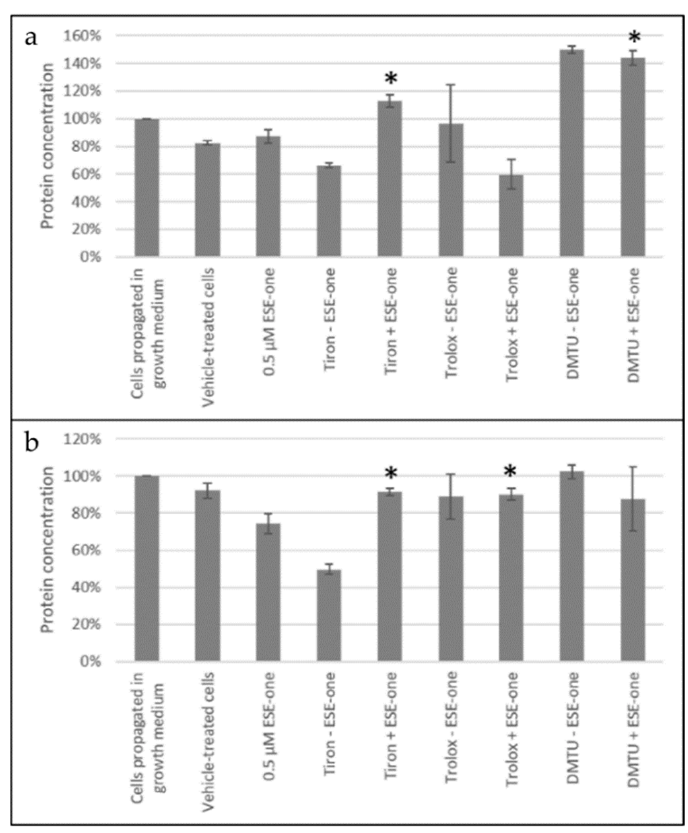
Figure 7. Catalase activity graphs of MCF-7 and MDA-MB-231 cells exposed to ESE-one in the presence or absence of scavengers of reactive oxygen species (tiron, trolox and DMTU). Tiron and DMTU coexposure with ESE-one increased the catalase protein concentration significantly in MCF-7 cells and in MDA-MB-231 cells, tiron and trolox induced a significant increase in catalase protein concentration. ( a ) MCF-7, ( b ) MDA-MB-231. An asterisk (*) indicates p -value ( p < 0.05) compared to ESE-one treated cells.